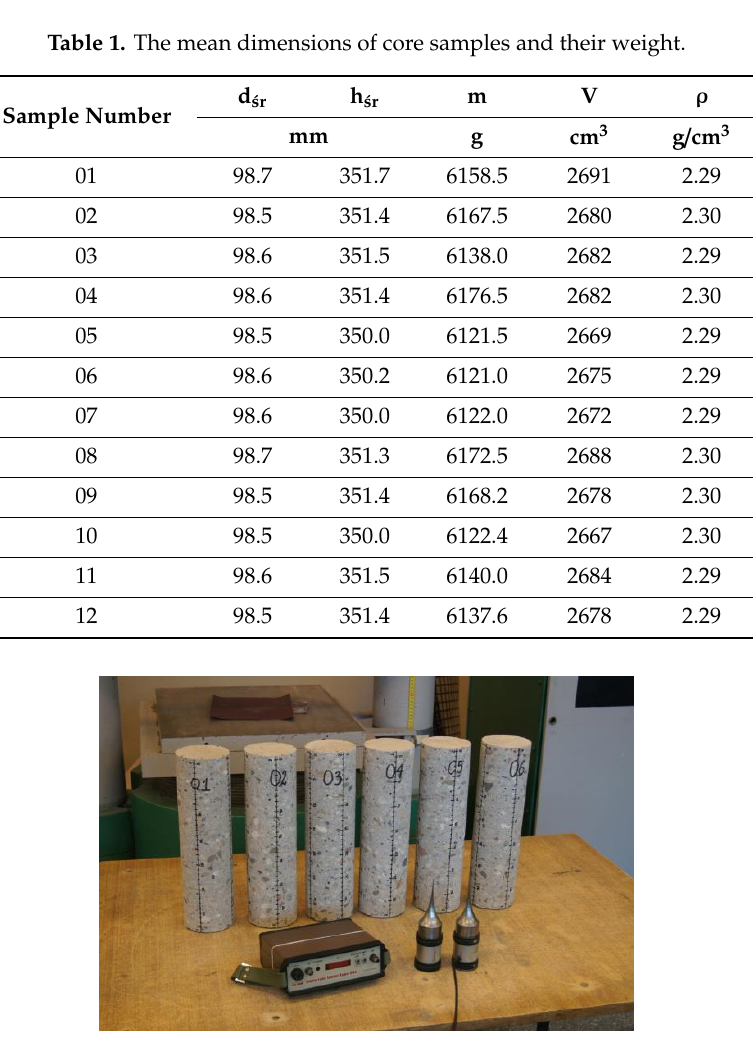
Table 1. The mean dimensions of core samples and their weight.